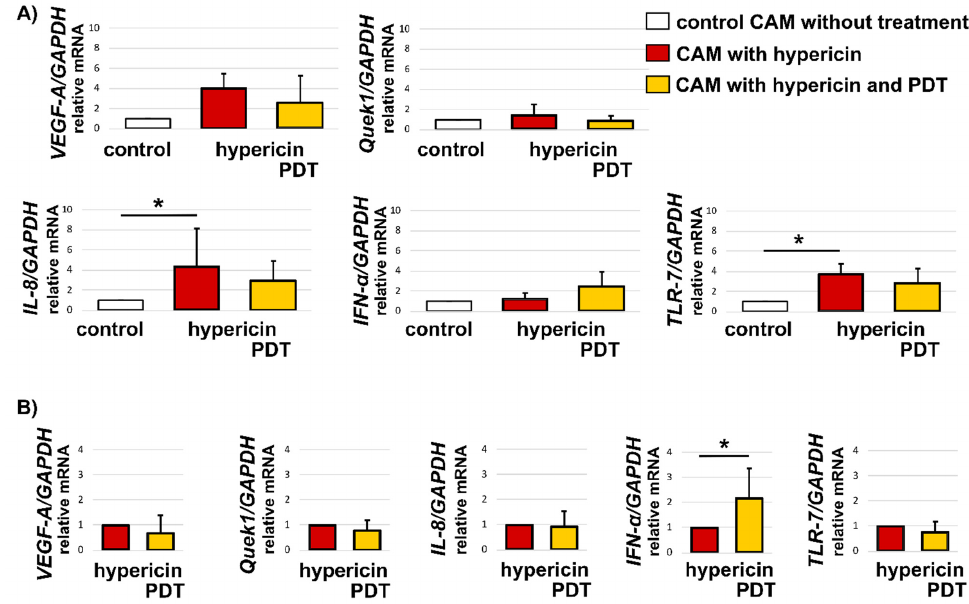
Figure 11. Relative expression of VEGF-A , Quek1 , IL-8 , IFN- α , TLR-7 normalized to the GAPDH gene from CAM without spheroids and hypericin application (control, white columns), with 500 nM hypericin in the dark (red columns), and with hypericin and PDT application (yellow columns). Reference in ( A ) was an untreated control and ( B ) hypericin in the dark. Error bars represent standard deviations from the mean (n = 4–5). The degree of significant difference was determined using the one-way test ANOVA: * p < 0.05.